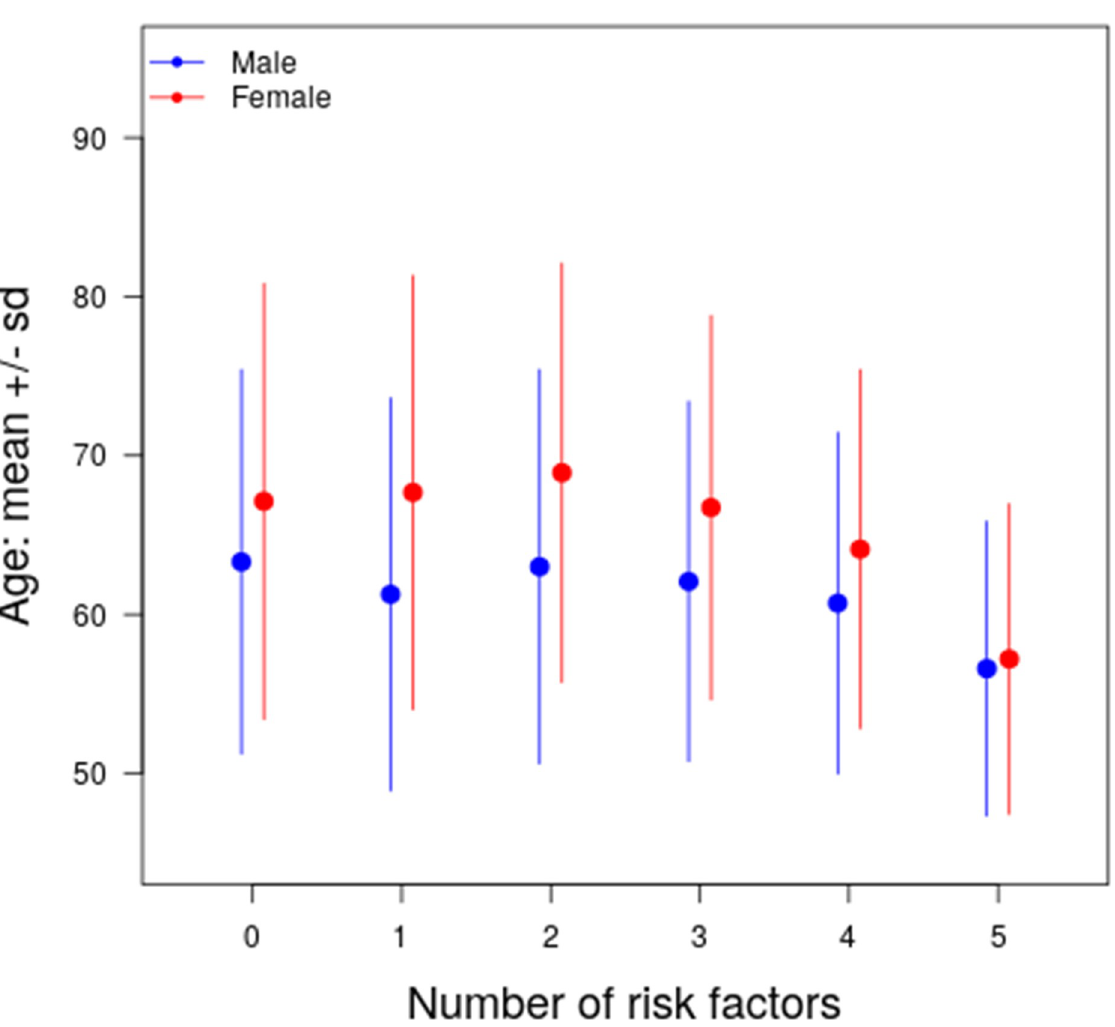
Fig 1. Age at the time of presentation for PCI by the number of risk factors stratified by gender. Risk factors include the presence of hypertension, diabetes, current/recent smoker, obesity, and dyslipidemia. Mean age (dot) and standard deviation (lines) of men and women are shown in blue and red,